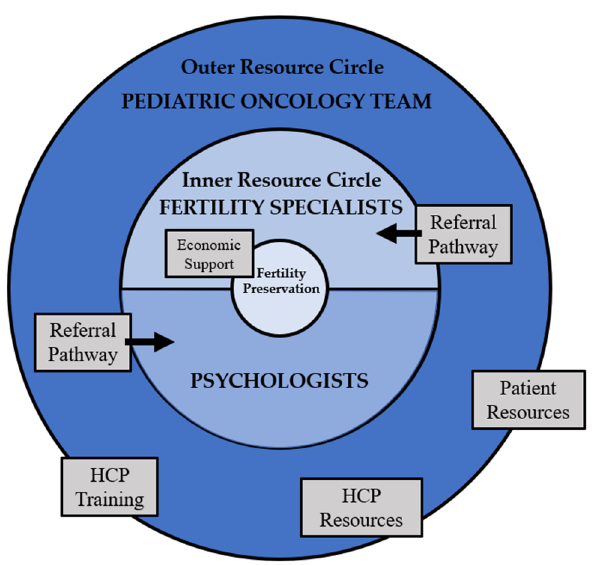
Figure 1. Institutional model of care framework for adolescent fertility preservation—resource circles adapted from Ronn & Holzer [86]. (Health care provider abbreviated as HPC)